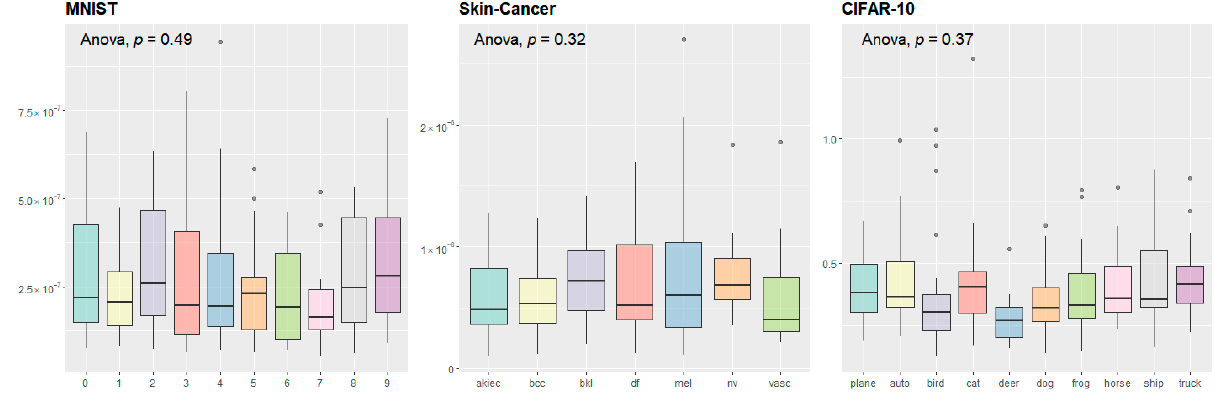
Figure 5. Decryption error statistics of di ff erent categories.